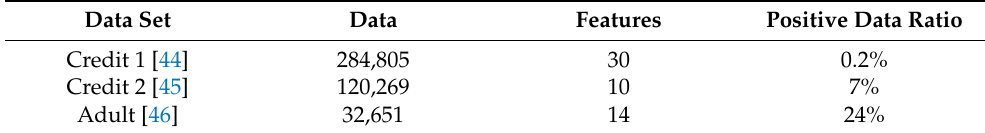
Table 4. Experimention on the dataset. The task in the following dataset is binary classification. Data Set